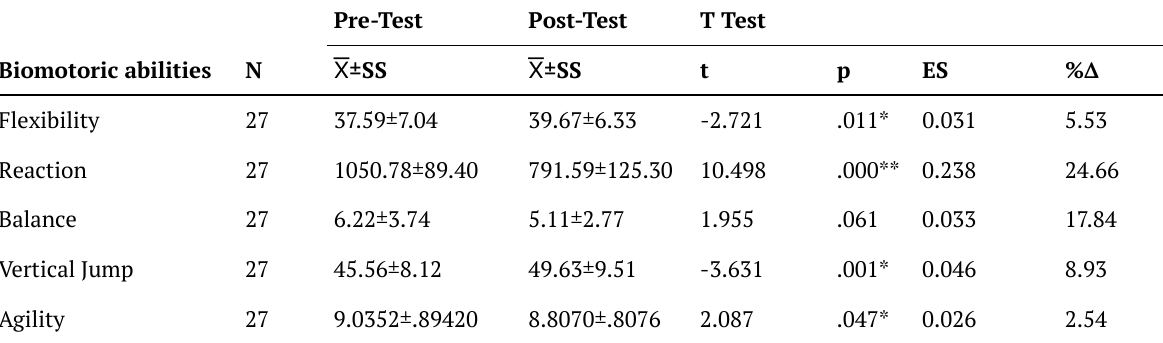
Table 3. Findings of the difference before and after badminton